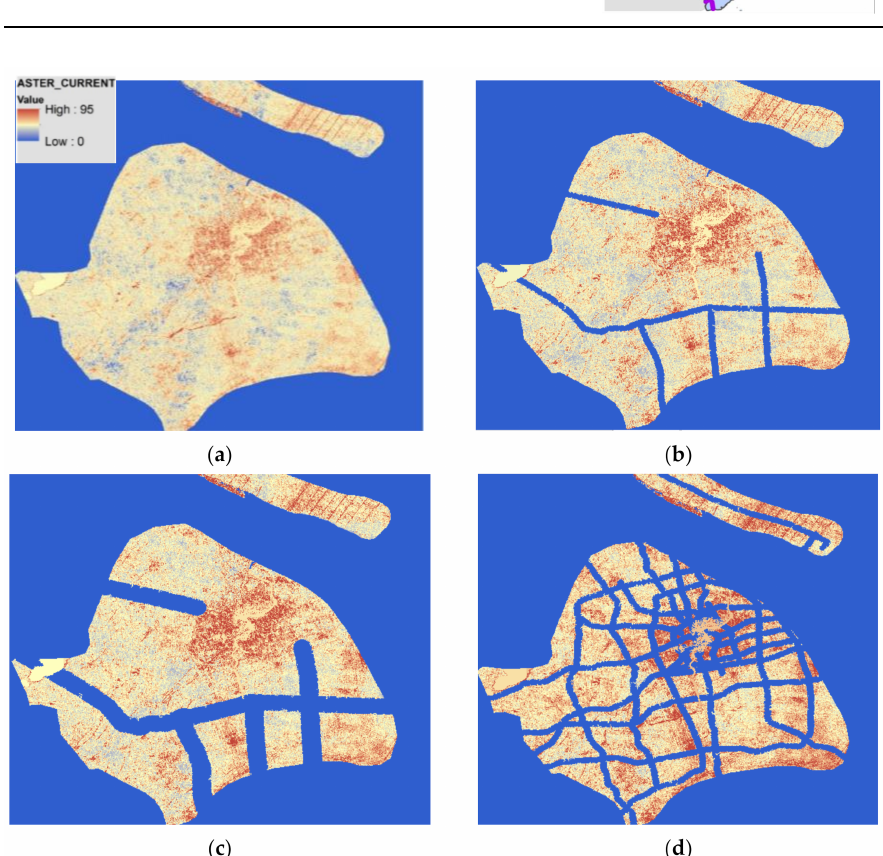
Figure 3. Base and VC morphology maps of Shanghai, China: ( a ) base; ( b ) VC_ECO2KM; ( c ) VC_ECO5KM; ( d )